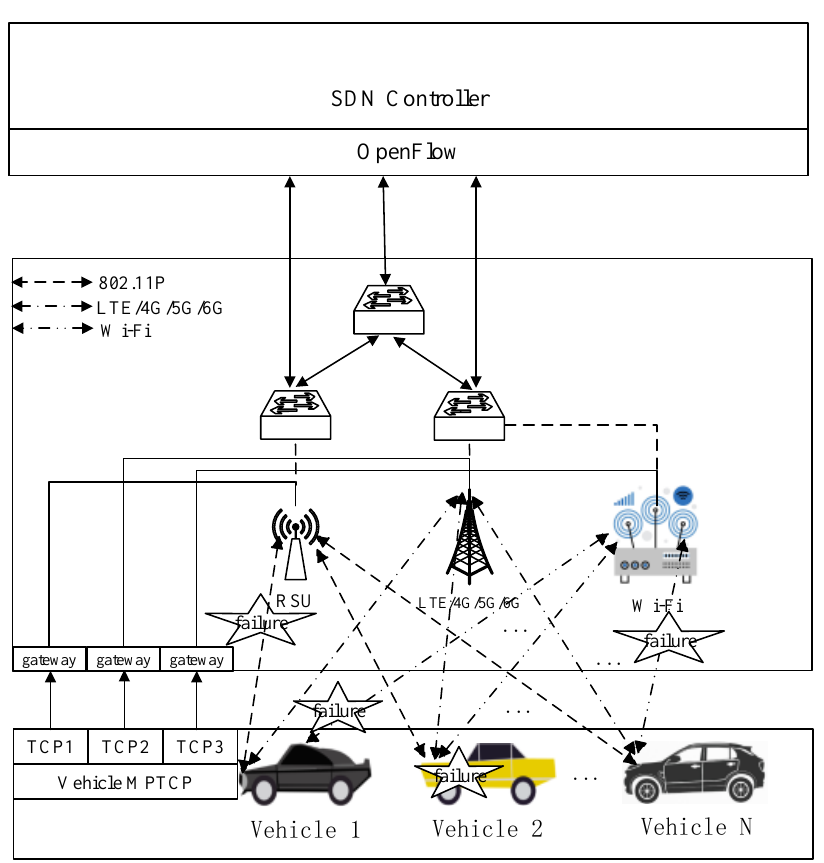
Figure 2. SDN-based V2I network communication model.